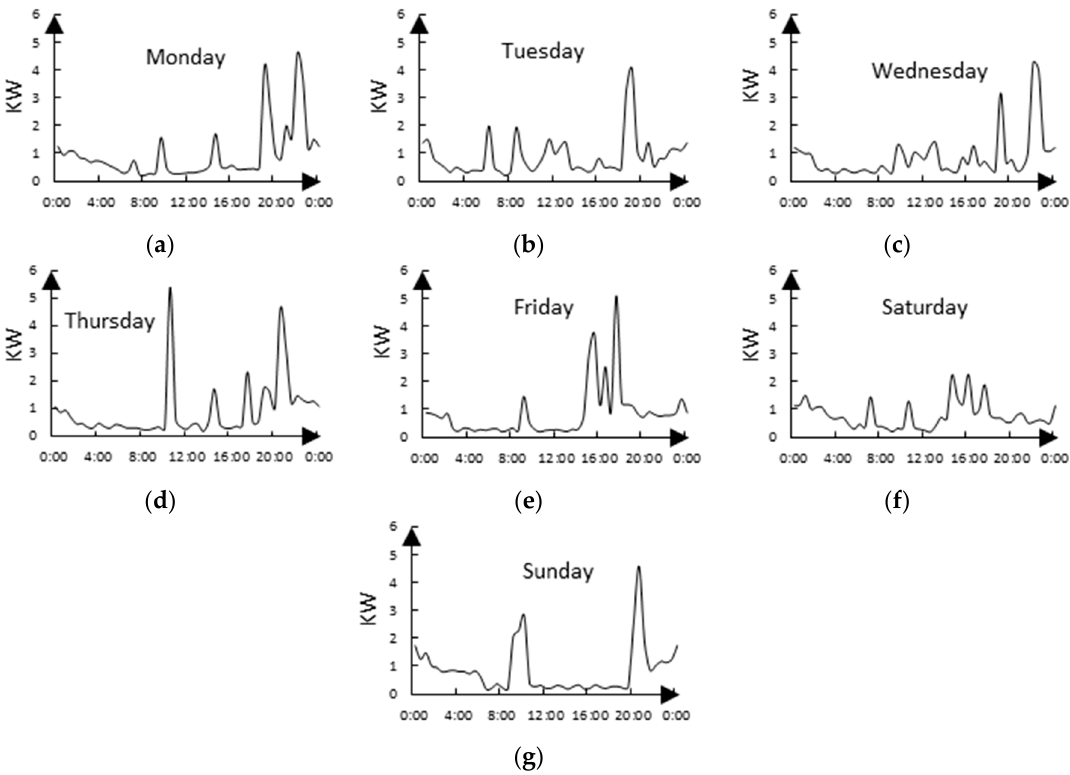
Figure 3. Load curves of a domestic user from 19 July 2009 to 25 July 2009. ( a ) The user load curve on 20 July; ( b ) The user load curve on 21 July; ( c ) The user load curve on 22 July; ( d ) The user load curve on 23 July; ( e ) The user load curve on 24 July; ( f ) The user load curve on 25 July; ( g ) The user load curve on 19 July.